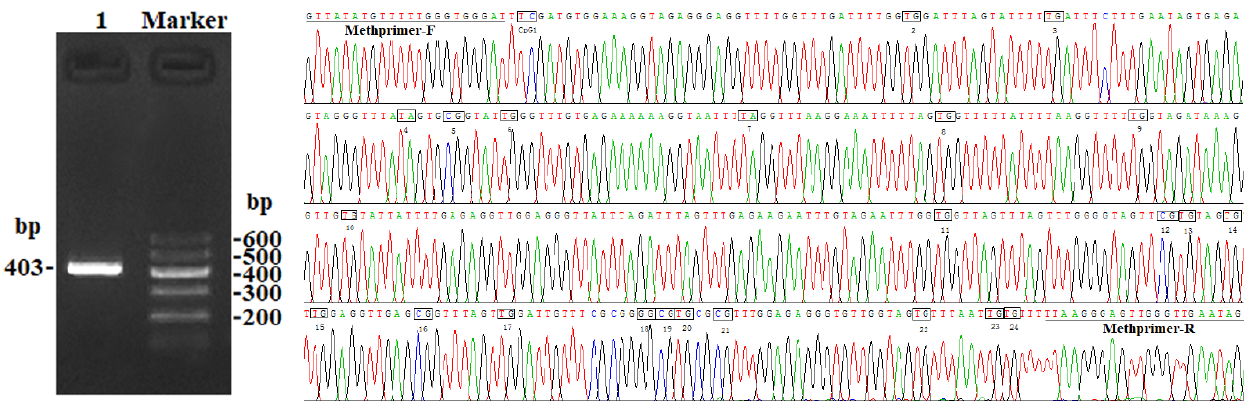
Figure 2. PCR electrophoresis diagram and bisulfite sequencing maps of the goat PITX1 CpG